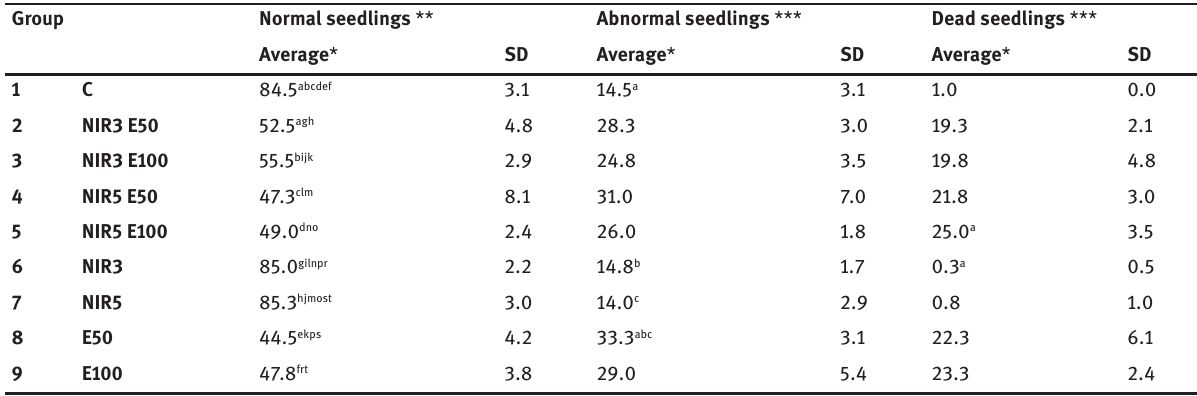
Table 2: The number of normal, abnormal and dead seedlings in the tested groups.